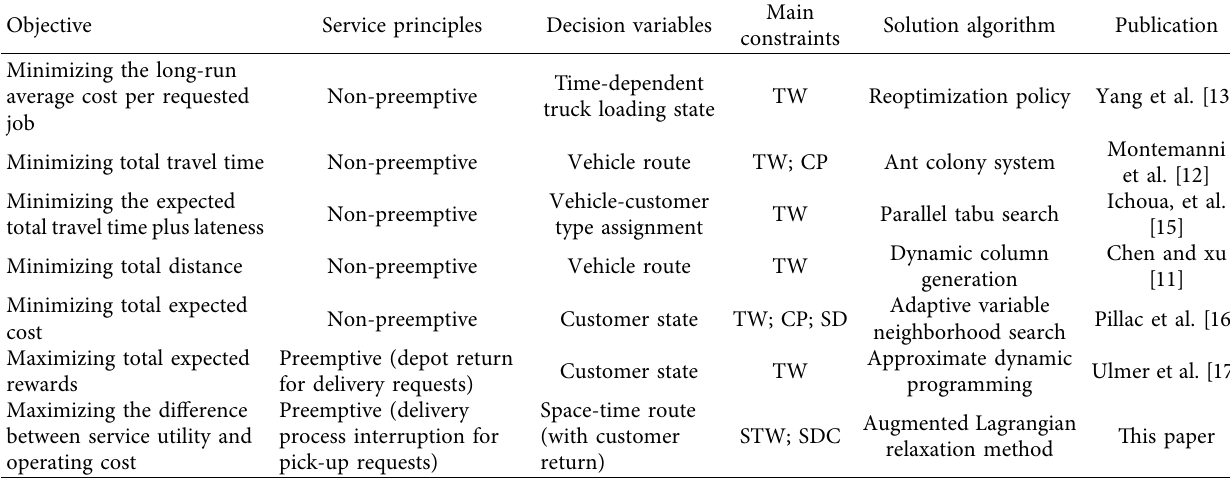
Table 1: Comparison of key elements in DVRPTW.